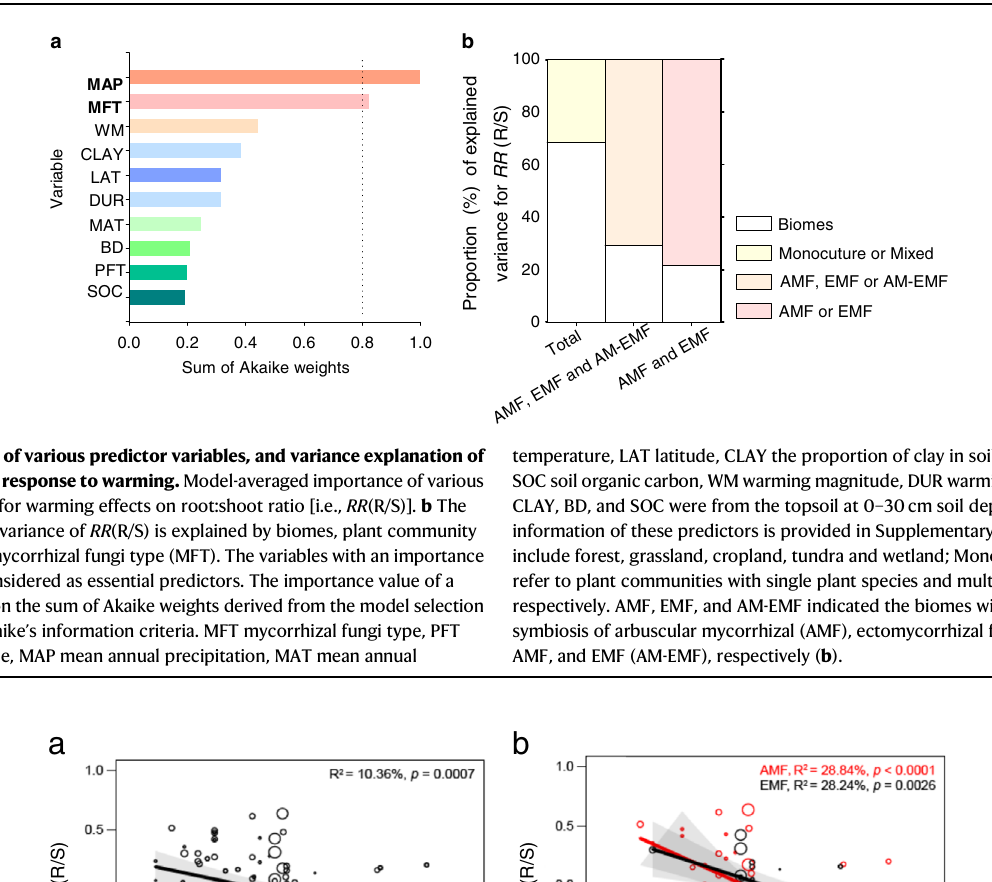
Fig. 4 | Correlations between mean annual precipitation and response of root:shoot ratio to warming. a Correlations between mean annual precipitation (MAP, mm) and the response ofroot:shootratio [ RR (R/S)]. b Correlations between MAP and RR (R/S) in biomes with dominant root symbiosis of arbuscular mycor- rhizaland ectomycorrhizal fungi(AMF and EMF), respectively. The sizeof the data